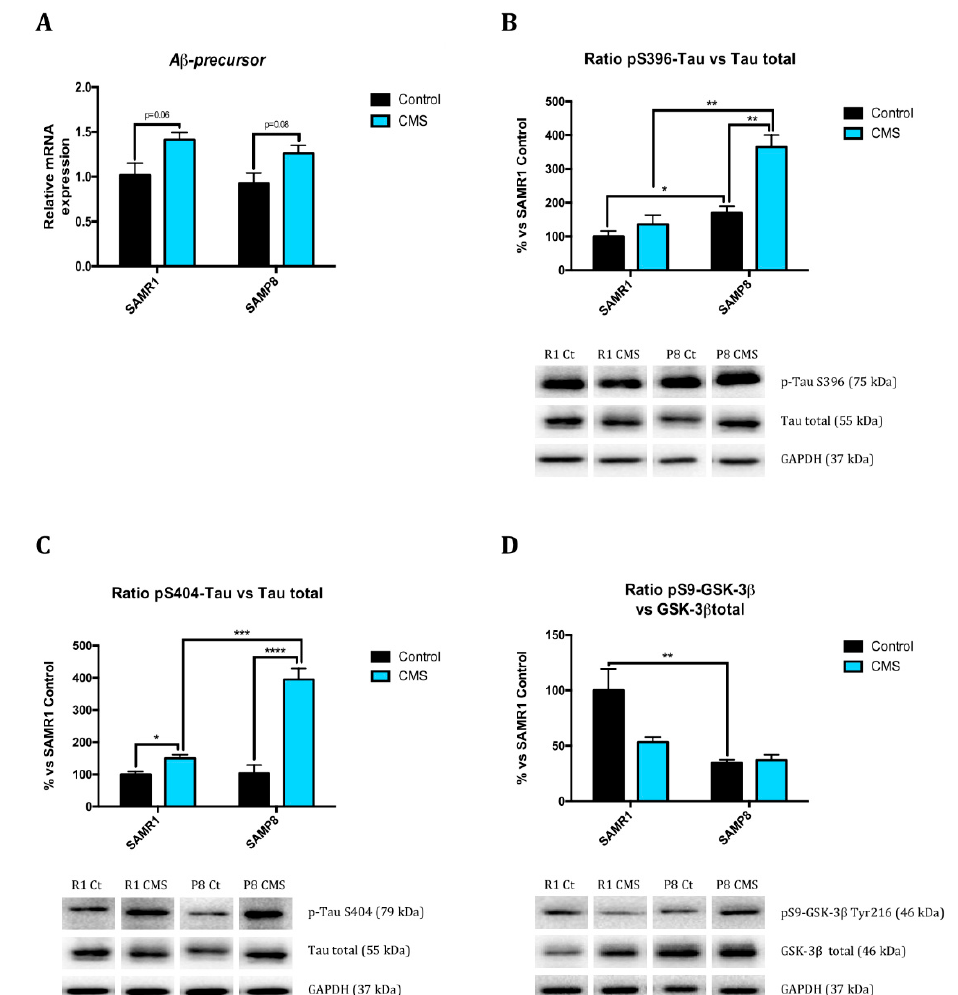
Figure 5. AD hallmarks changes after CMS. Relative gene expression of A β -precursor ( A ). Representative Western Blot for the ratio of pS396-Tau protein levels and quantification ( B ), the ratio of pS404-Tau protein levels and quantification ( C ), and the ratio of pS9-GSK-3 β protein levels and quantification ( D ). Gene expression levels were determined by real-time PCR. Values in bar graphs are adjusted to 100% for protein levels of SAMR1 control (R1 Ct). Values are mean ± Standard error of the mean (SEM); ( n = 4 for each group). * p < 0.05; ** p < 0.01; *** p < 0.001; **** p < 0.0001.